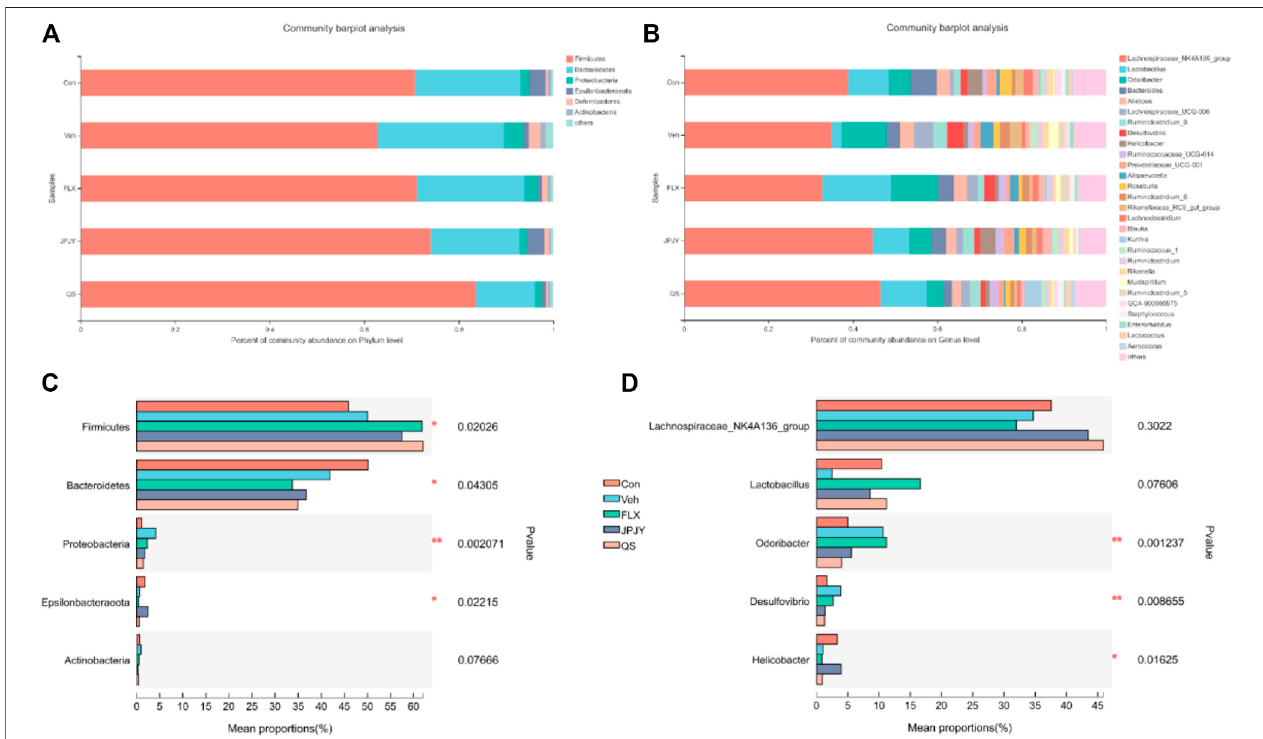
FIGURE 4 | Related phylum and genus level bacterial abundance. (A) Bacterial taxonomic pro fi ling in the phylum level of gut microbiota from different groups. (B) Bacterialtaxonomic pro fi lingin thegenus level ofintestinal bacteriafrom different groups. (C) Kruskal-WallisHtest bar plot of Firmicutes , Proteobacteria , Bacteroidetes , Actinobacteria and Deferribacteres in phylum level. (D) Kruskal-Wallis H test bar plot of Lactobacillus, Lachnospiraceae _NK4A136_group , Odoribacter , desulfovibrio , and helicobacter in genu level.